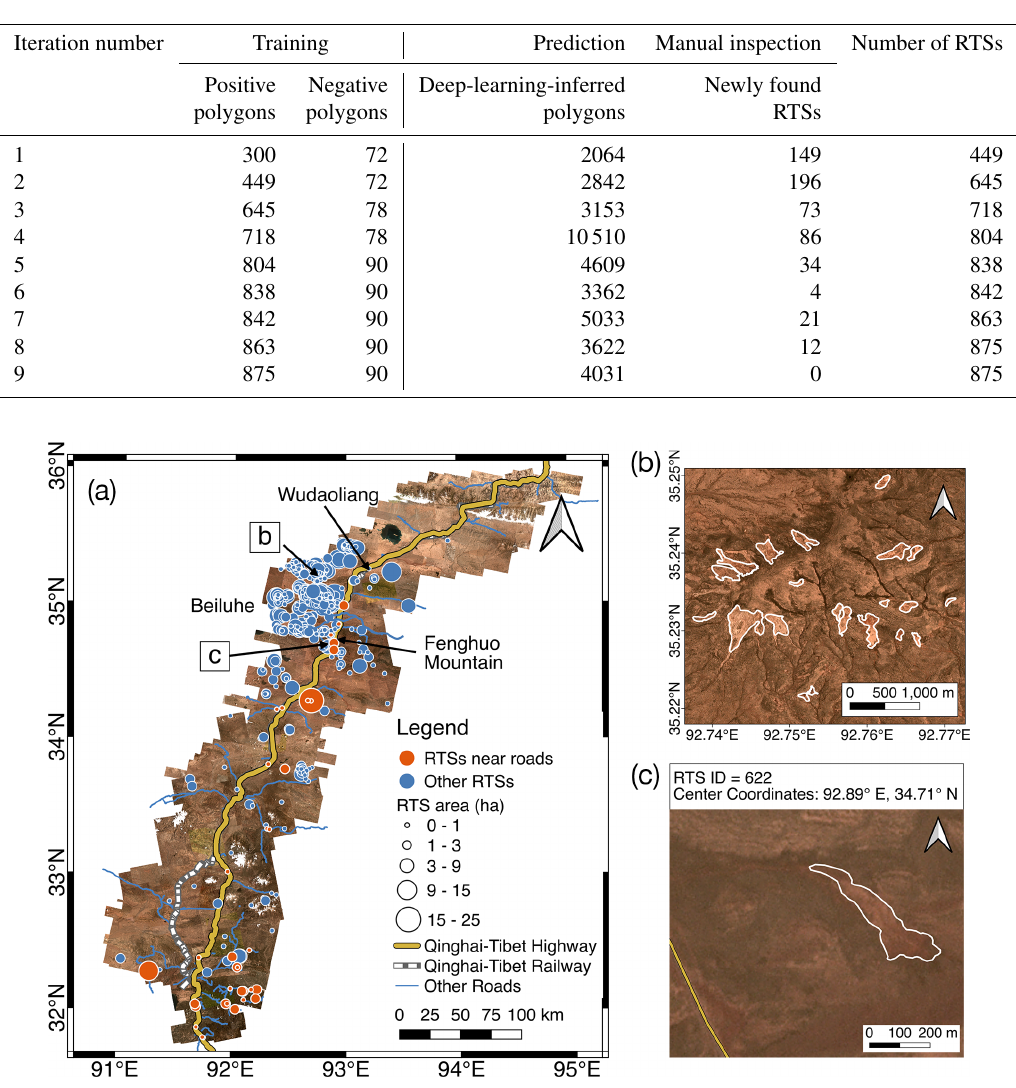
Figure 5. (a) The map of the 875 delineated RTSs. The circle sizes indicate the RTSs’ area. Orange circles are RTSs close to roads, whereas blue circles show other RTSs. (b) Examples of the delineated RTSs in the Beiluhe region, with the white polygons representing the boundaries of RTSs. (c) An example of an RTS adjacent to the Qinghai–Tibet highway (yellow line). Basemap images © Planet Labs